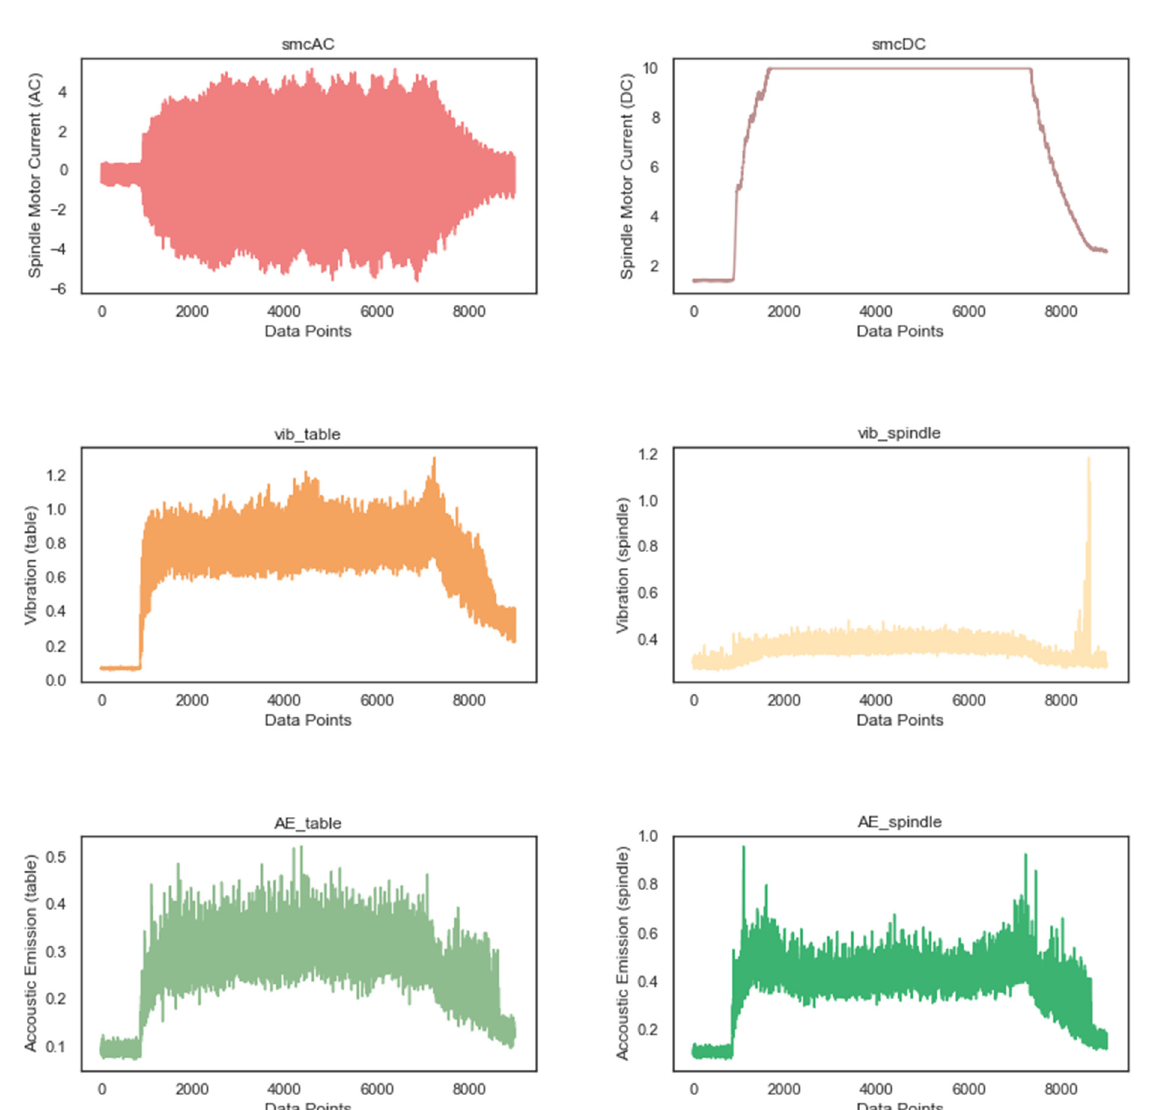
Figure A1. Signatures from the six sensor signals for case 1, run 11.